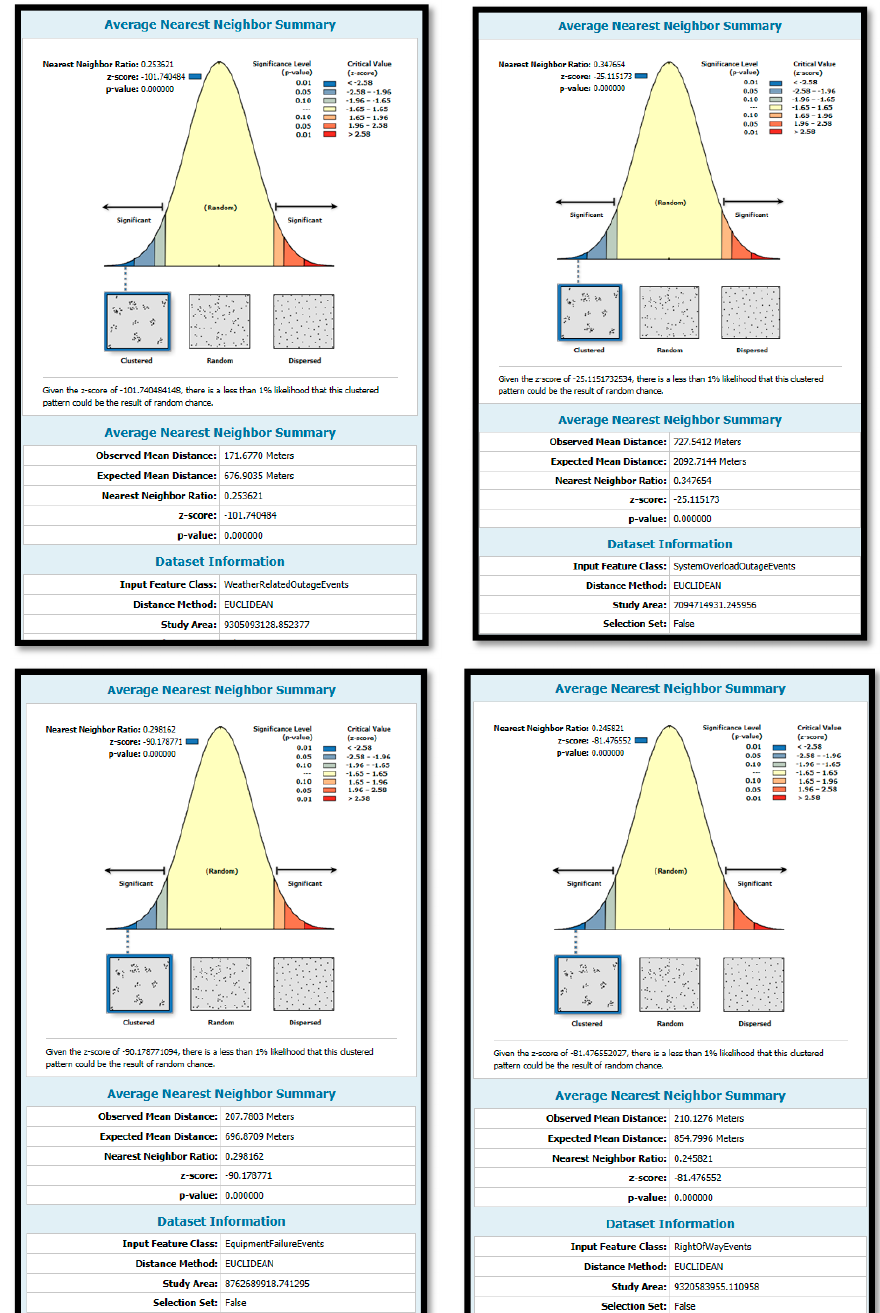
Figure 8. ArcGIS average nearest neighbor analyses results for four types of outages: weather ( top left ), system overload ( top right ), equipment ( bottom left ), and right of way ( bottom right ).